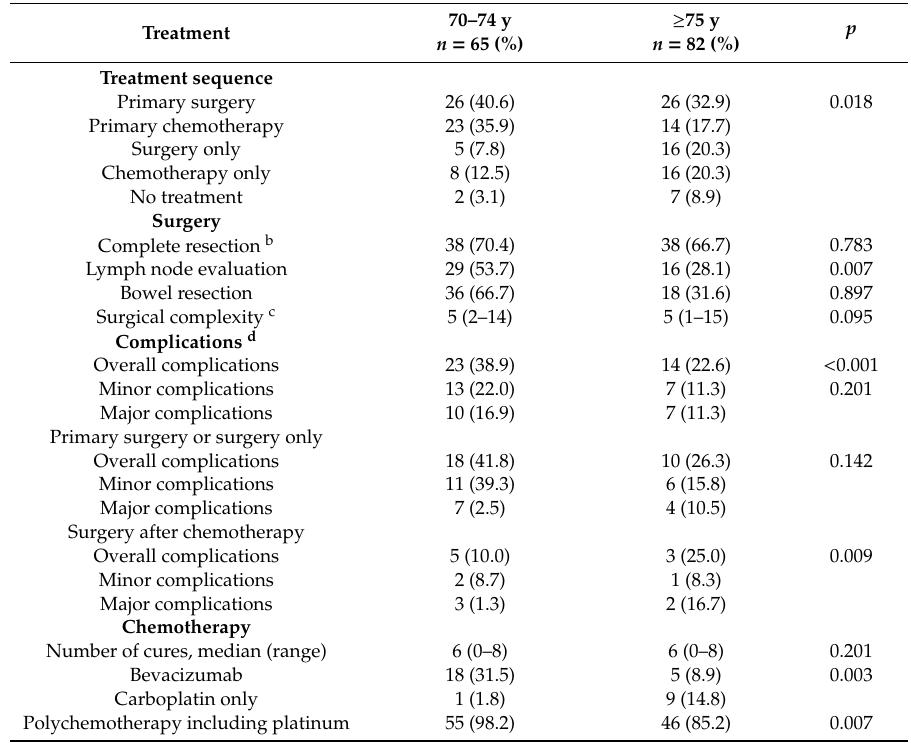
Table A2. Treatment stratified by age a .